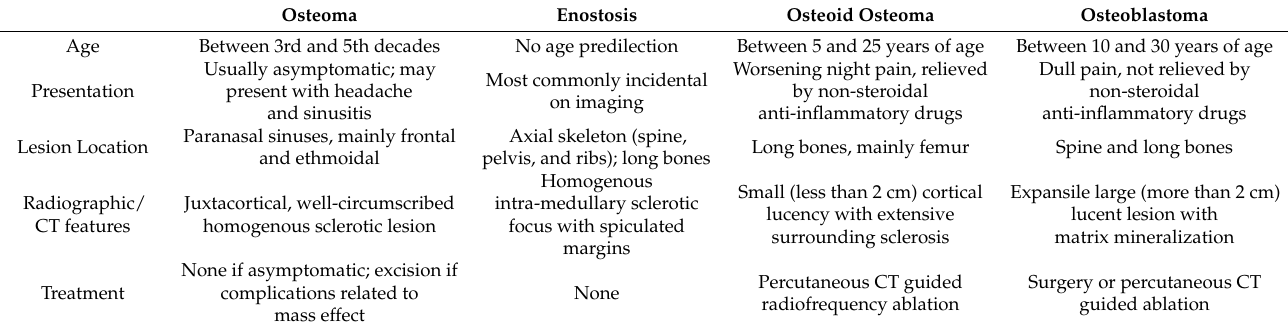
Table 1. Important features to differentiate pediatric benign osteocytic bone